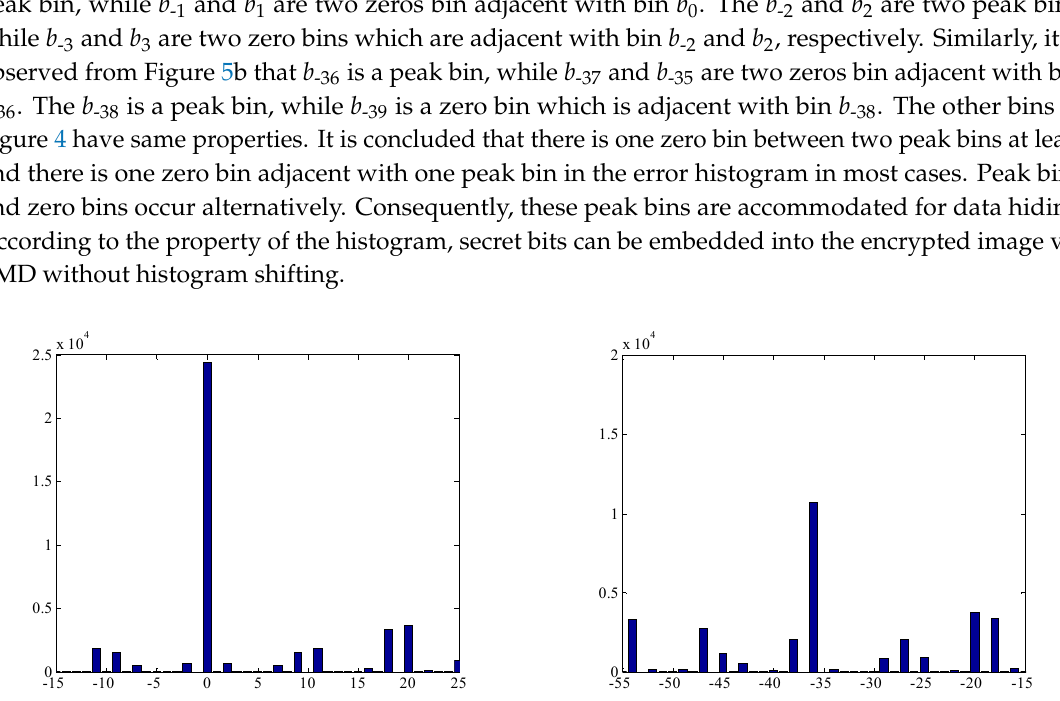
Figure 6. Two Expanding schemes. ( a ) Expanding scheme: E1. ( b ) Expanding scheme: E2.